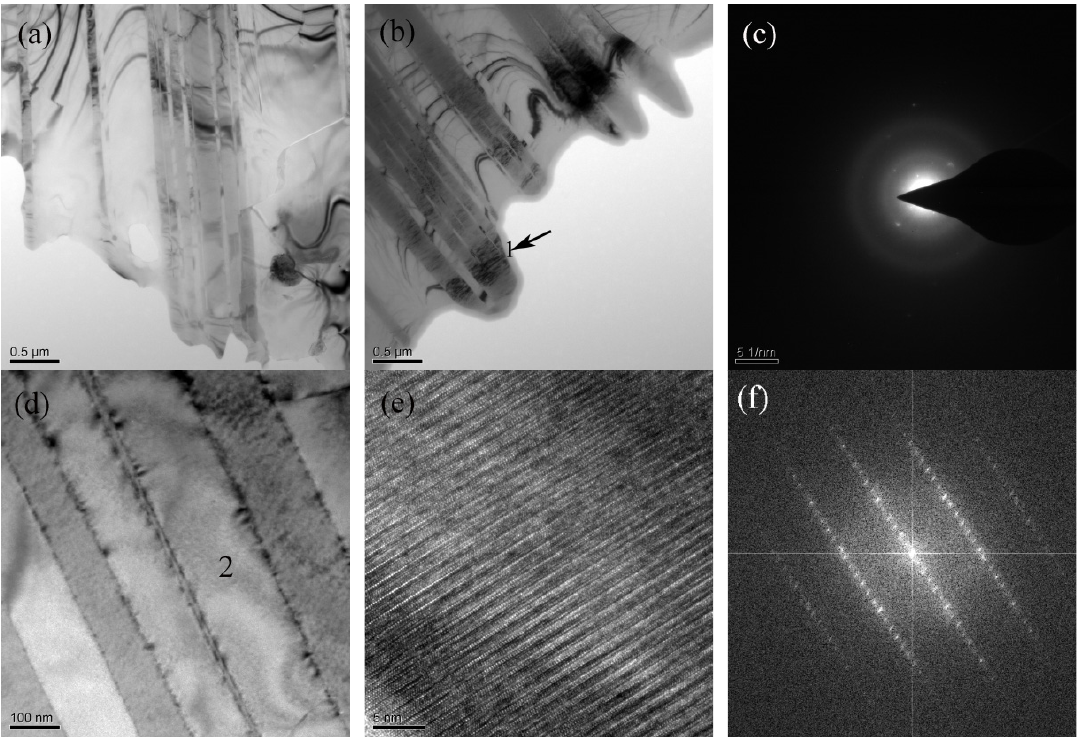
Figure 3. TEM images of the irradiated samples with helium ions at 298 K to a fluence of ( a ) 0, ( b , d ) 1 × 10 21 ions/m 2 with the diffraction pattern in ( c ) for position 1 in ( b ), the HRTEM images for position 2 shown in ( e ) and the corresponding FFT image in ( f ).